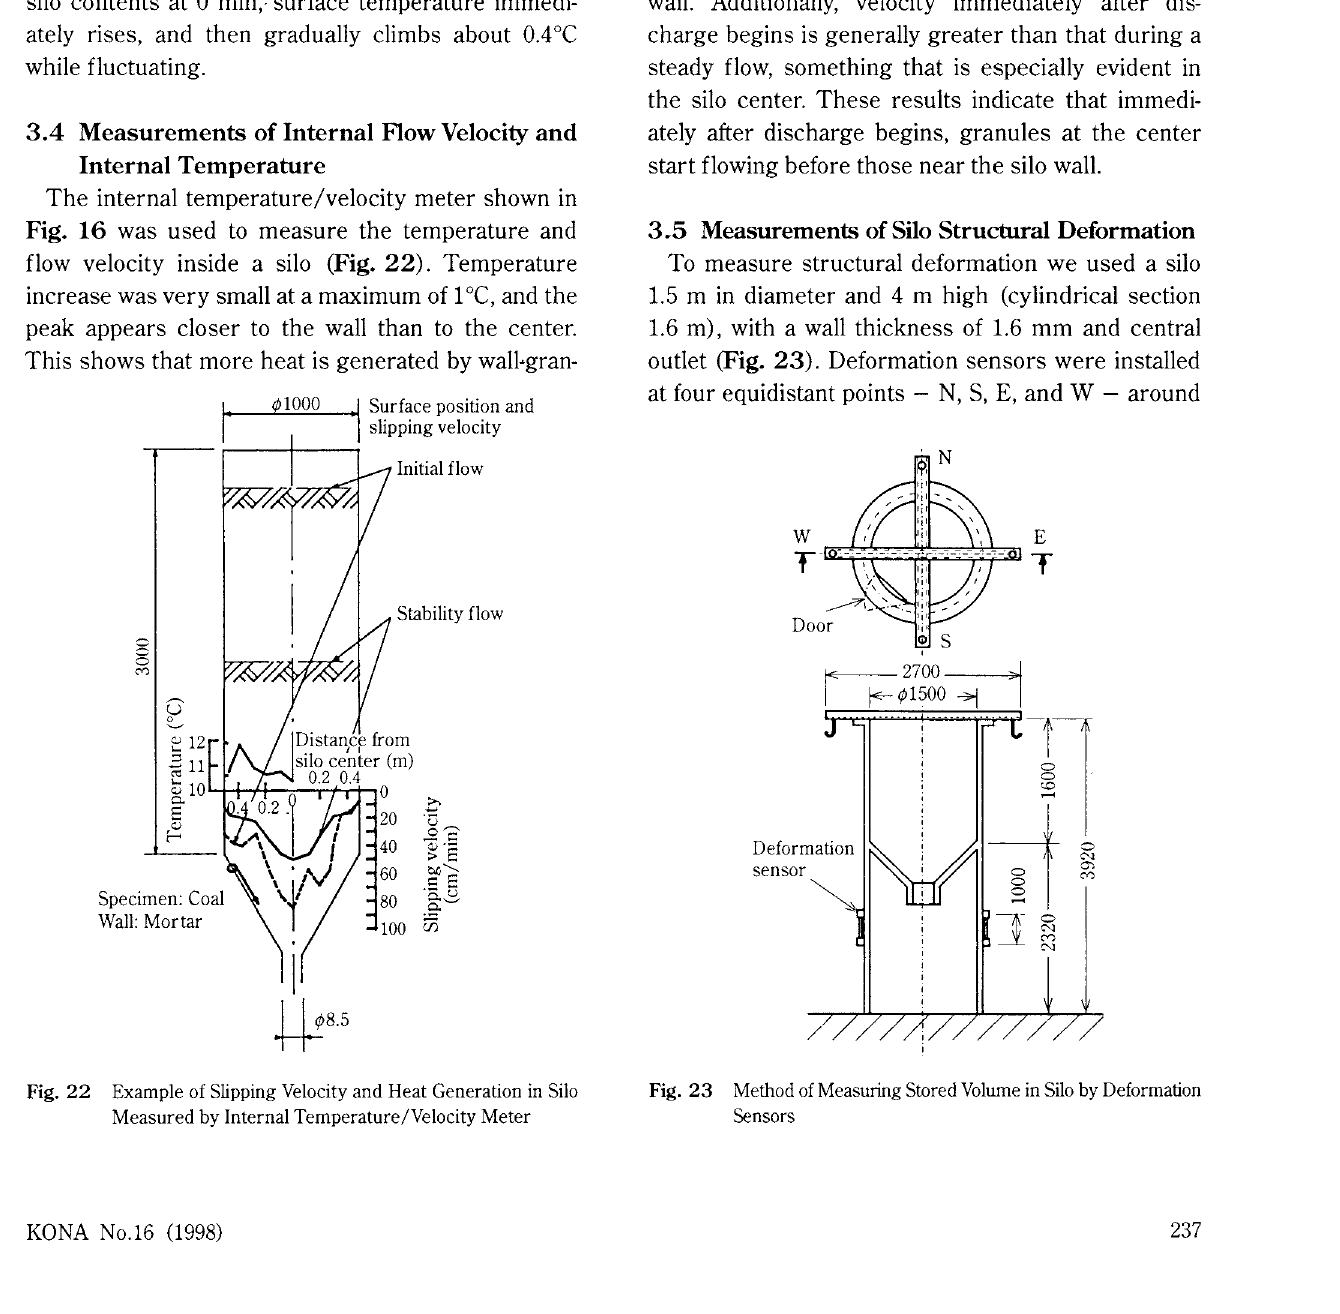
Fig. 22 Example of Slipping Velocity and Heat Generation in Silo Measured by Internal Temperature/Velocity Meter